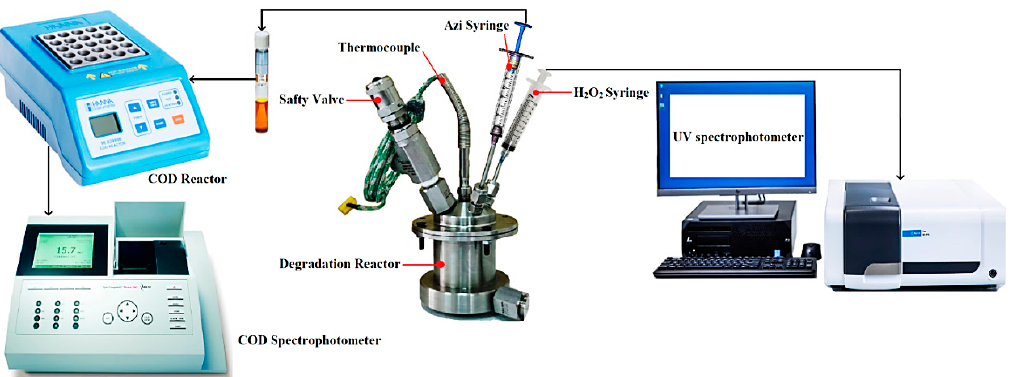
Figure 1. Scheme of the used setup for hydrogen peroxide catalytic activation and Azi removal.